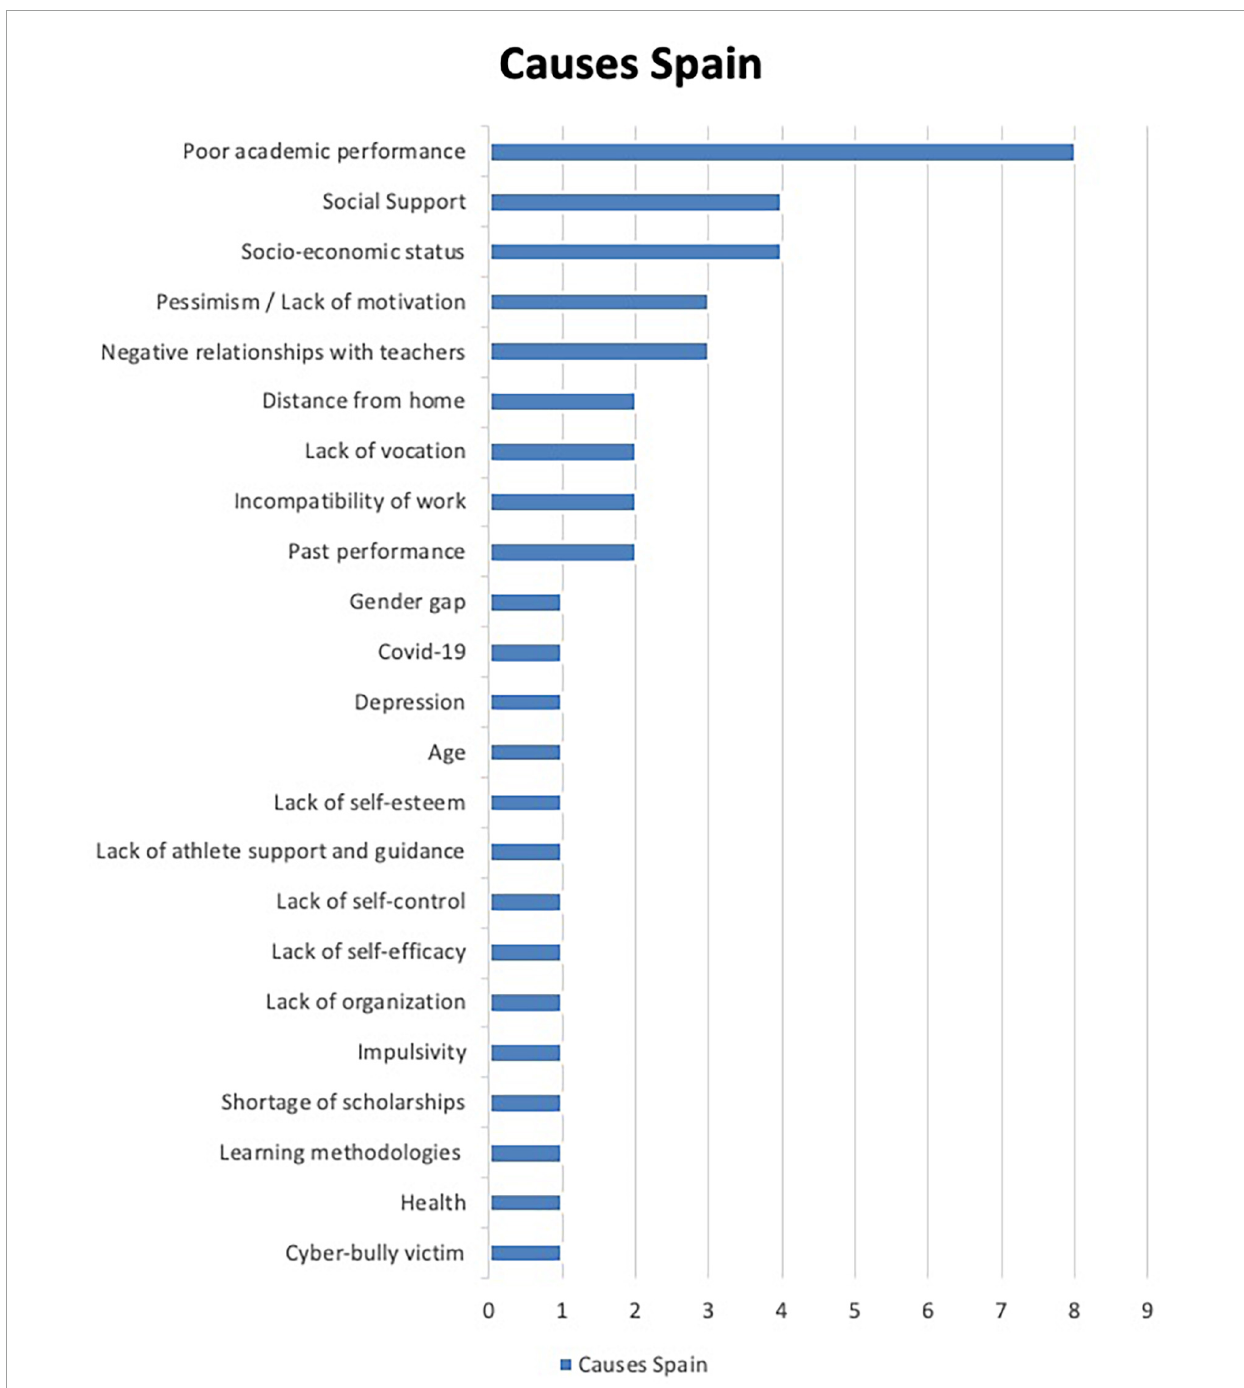
FIGURE3 Causes of academic dropout in Spain. Source: Own